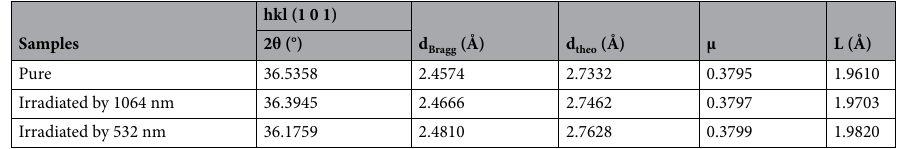
Table 3. Zn–O bond lengths, and the inter-planer d-spacing of ZnO nanoparticles before and after irradiated with lasers having wavelengths of 532 nm and 1064 nm .